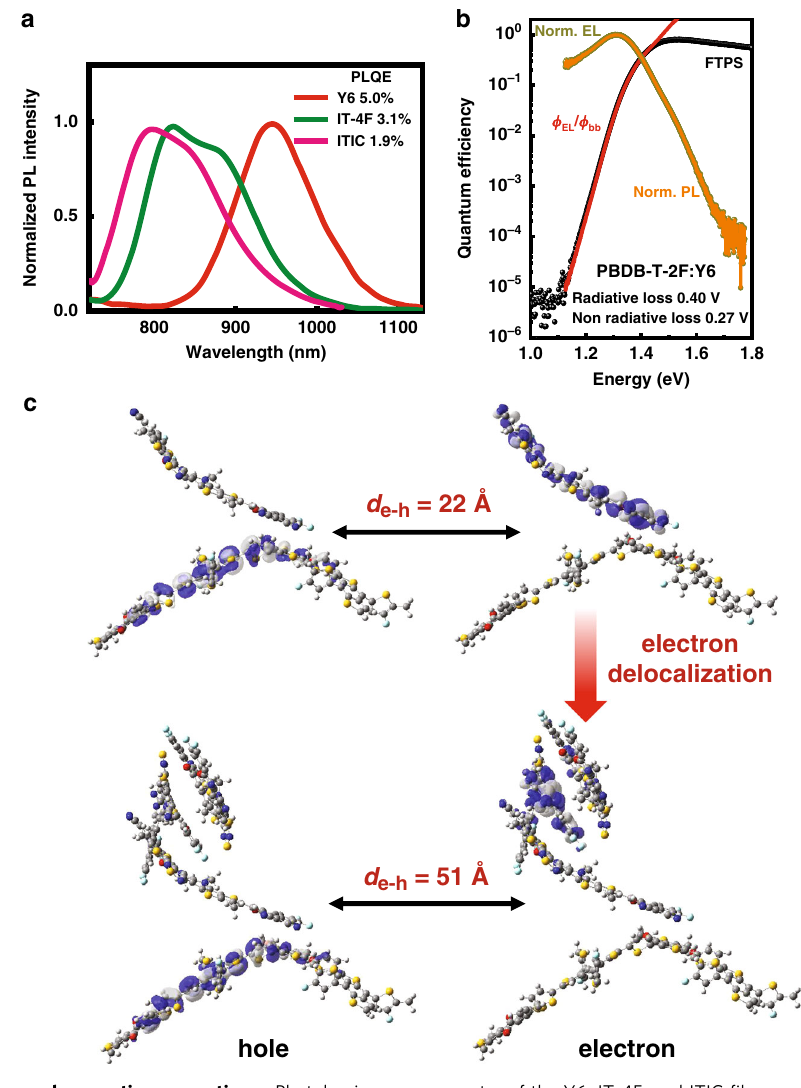
Fig. 4 Charge recombination and separation properties. a Photoluminescence spectra of the Y6, IT-4F, and ITIC fi lms excited at 660 nm together with their quantum ef fi ciencies. b Semi-logarithmic plots of EQE evaluated by FTPS (EQE FTPS ) (black spheres) and normalized EL (dark yellow spheres) as a function of energy for devices based on PBDB-T-2F:Y6. The ratio of ϕ EL / ϕ bb was used to plot the EQE in the low energy regime (red line), where ϕ EL and ϕ fl ux and the room-temperature blackbody photon fl ux, respectively. The normalized PL spectra (orange lines) were bb represent the emitted photon measured based on the binary blend fi lms. c Natural transition orbitals of the interfacial CT states by using the TD- ω B97XD/6-31G(d,p) method coupled with the PCM model for molecular clusters (left: one PBDB-T-2F donor fragment with one Y6 molecule; right: one PBDB-T-2F donor fragment with three Y6 molecules). Due to the delocalization of the electron wavefunction, the estimated distance ( d e – h ) between the hole and electron at the donor/acceptor interface increases from 22 Å for one Y6 molecule to 51 Å for clusters of three Y6